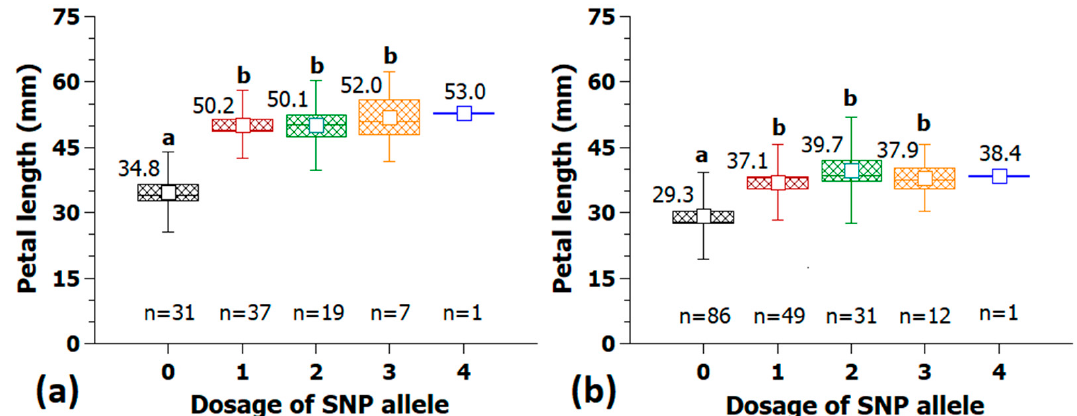
Figure 7. Validation of the KASP marker Rh_PL_SNP49K from the peak at 14.5 Mbp on chr5 for petal length with 95 cultivars in the association panel ( a ) and 179 independent tetraploid cultivars ( b ). On the x -axis are the allelic dosages for the four marker classes (0 and 4 for the homozygote classes and 1–3 for the heterozygotes), and on the y -axis, the petal length. Per allele dosage group, the number of individuals (n) is given on the bottom; groups that are significantly different at p ≤ 0.05 are indicated by letters above the whiskers (Kruskal-Wallis rank sum test); mean values are given above the box. Small white square = mean; continuous line = median; box = standard error; and whisker = standard deviation.